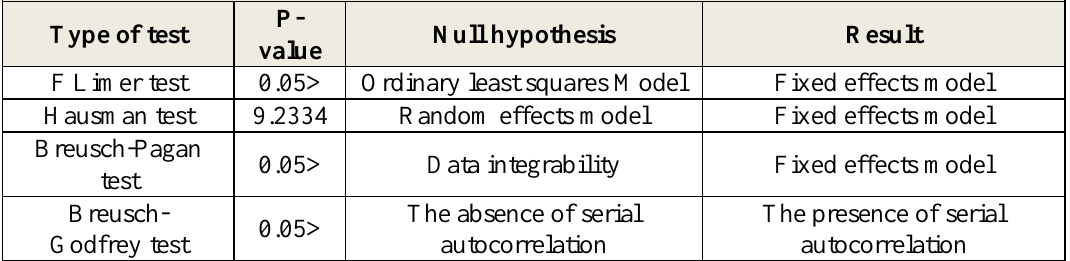
Table 5. The summary of diagnostic tests for the best second model for panel data fitting